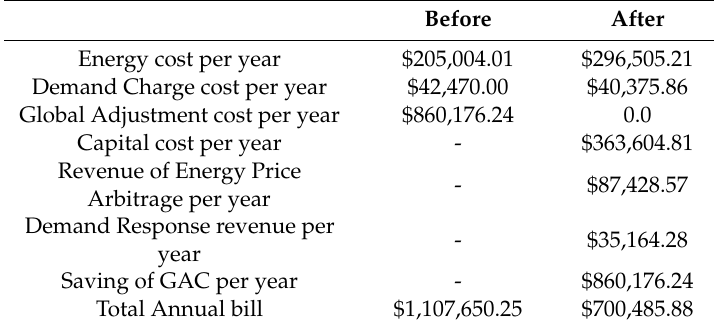
Table 2. Comparison between the bill components before and after the battery deployment. Before After